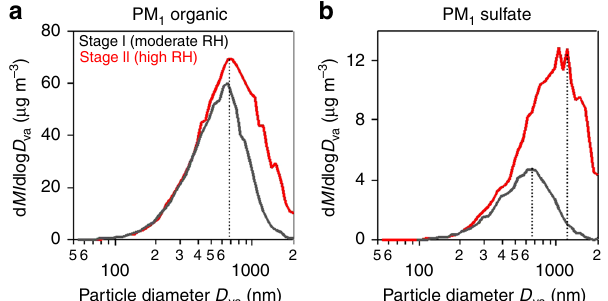
Fig. 2 Size distributions of organic and sulfate particles. The Figure shows mass-based size distributions of ( a ) organic and ( b ) sulfate particles in Stages I and II of the December 16 – 22, 2016 haze event. M denotes mass and D va denotes particle vacuum aerodynamic diameter. The measurements were made by the HR-AMS instrument with 50% size cut at 1- μ m diameter, hence the data are shown as PM 1 (particulate matter with less than 1- μ m diameter). Mass modal diameters are shown as dotted